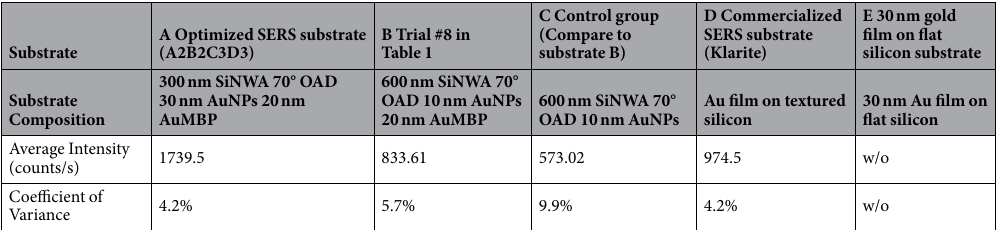
Table 2. The average intensity of peak sited at 1073 cm − 1 and coefficient of variance (C.V.) measured from different kinds of SERS substrates listed in Fig. 2. (The coefficient of variance (C.V.) is calculated by randomly choose five